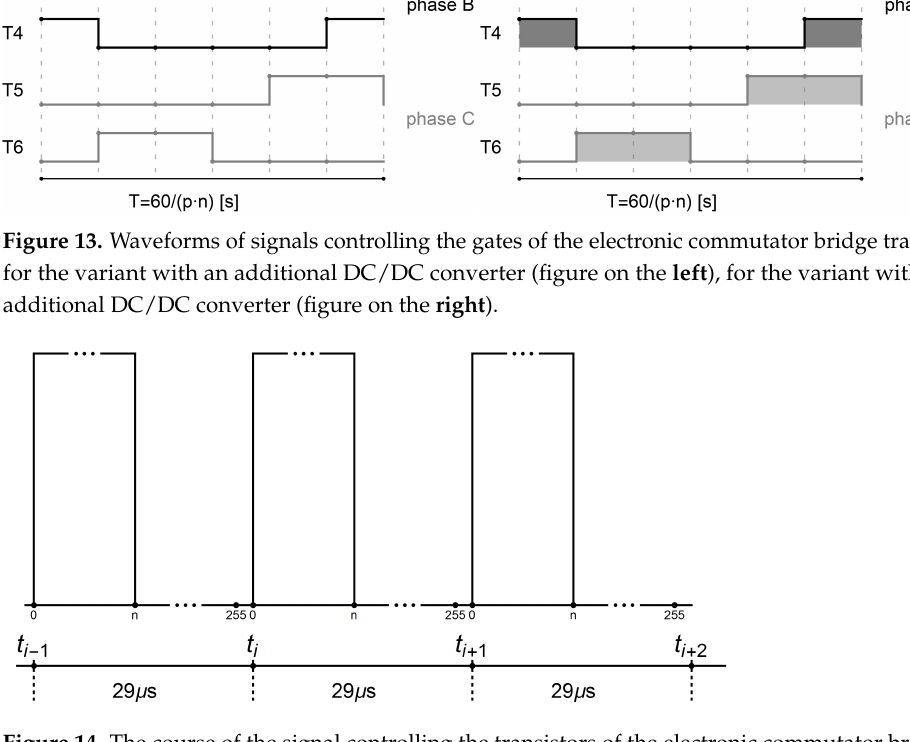
Figure 14. The course of the signal controlling the transistors of the electronic commutator bridge for the variant without an additional DC/DC converter.